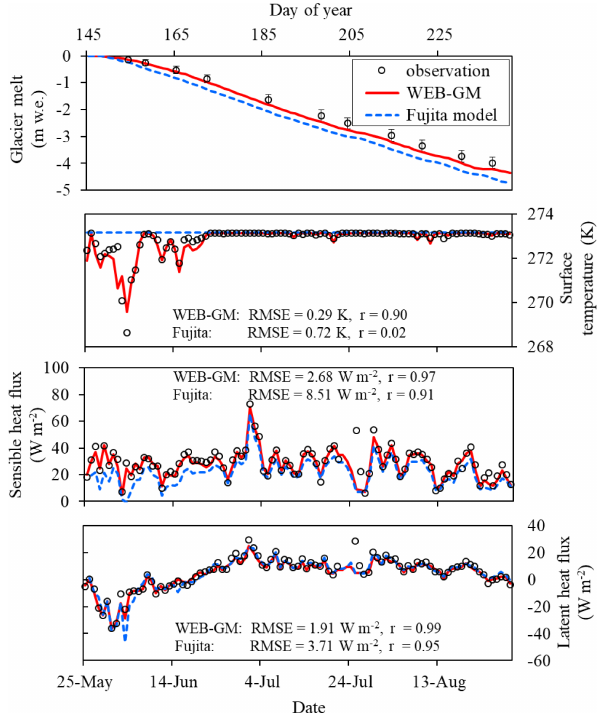
Figure 1. Comparisons of the WEB-GM and Fujita model in sim- ulating glacier melt (a) , surface temperature (b) , sensible (c) , and latent heat fluxes (d) at the Parlung No. 4 Glacier. The figure is re- produced from Ding et al.